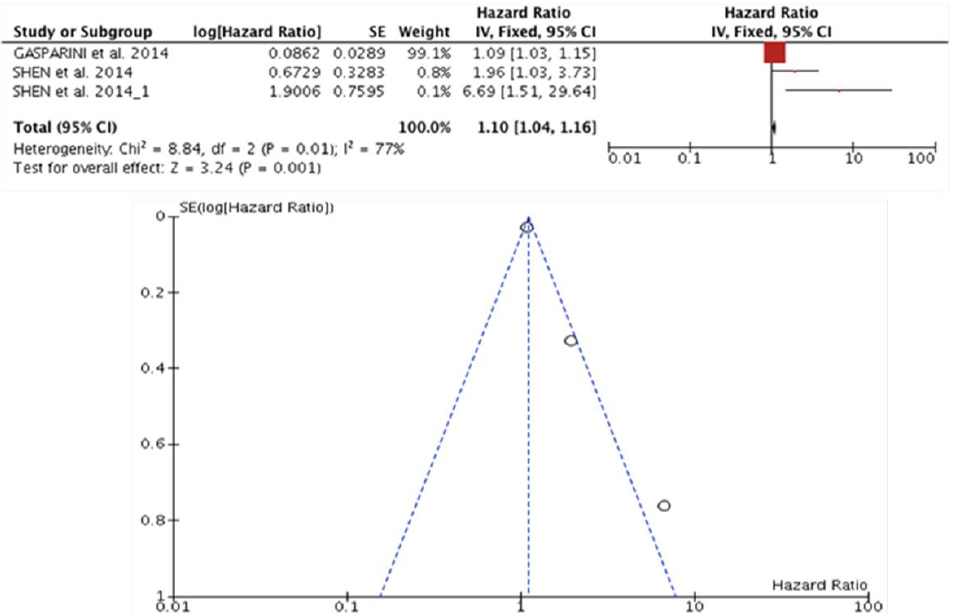
Figure 6. miR-301 and prognosis in TNBC. Forest and funnel plot observed effect of miR-301 a/b expression on OS in TNBC was not significant (HR: 0.82; 95% CI: 0.15–4.57; I 2 = 92%, p < 0.00001), Z = 0, 22, ( p = 0.82) [29,68,74].